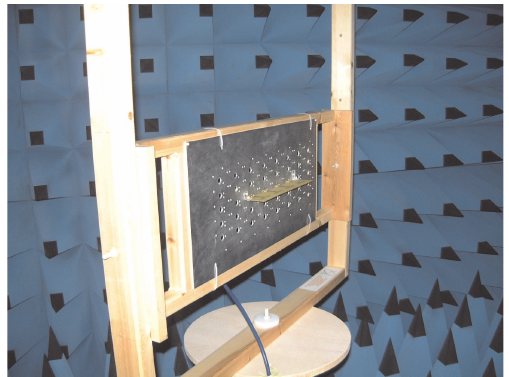
Figure 15: ULA array on reflector plate and wooden positioning structure in RF anechoic